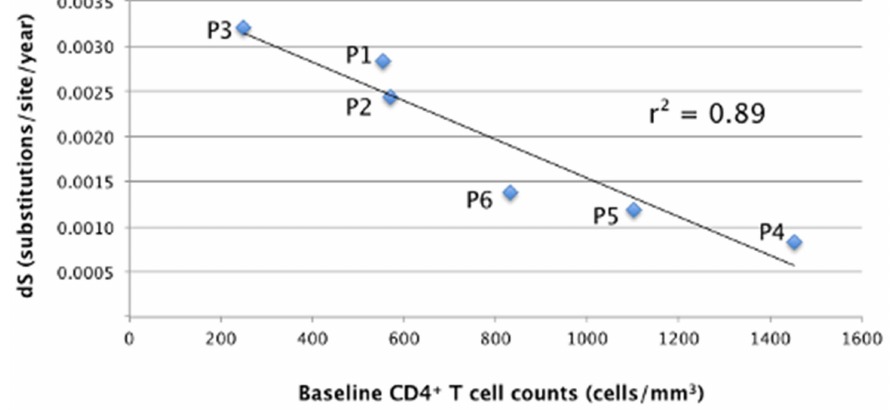
Figure 5. HIV-1 mean synonymous substitution rates along backbone paths vs . CD4 + T cell count at baseline for each subject. HIV-1 synonymous rates (dS) in gag p24 within each HLA-B*5701 subject (y-axis) were plotted against baseline CD4 + T cell counts (10–11 wpi). The squared correlation coefficient (r 2 ) is given in the graph and resulted highly significant ( p =0.002).